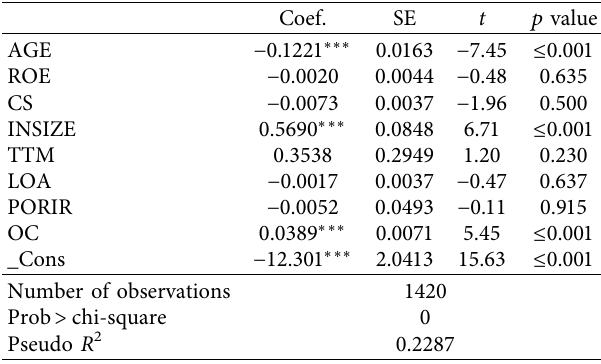
Table 6: Results of multiple regression of factors affecting whether government guiding funds make an investment.